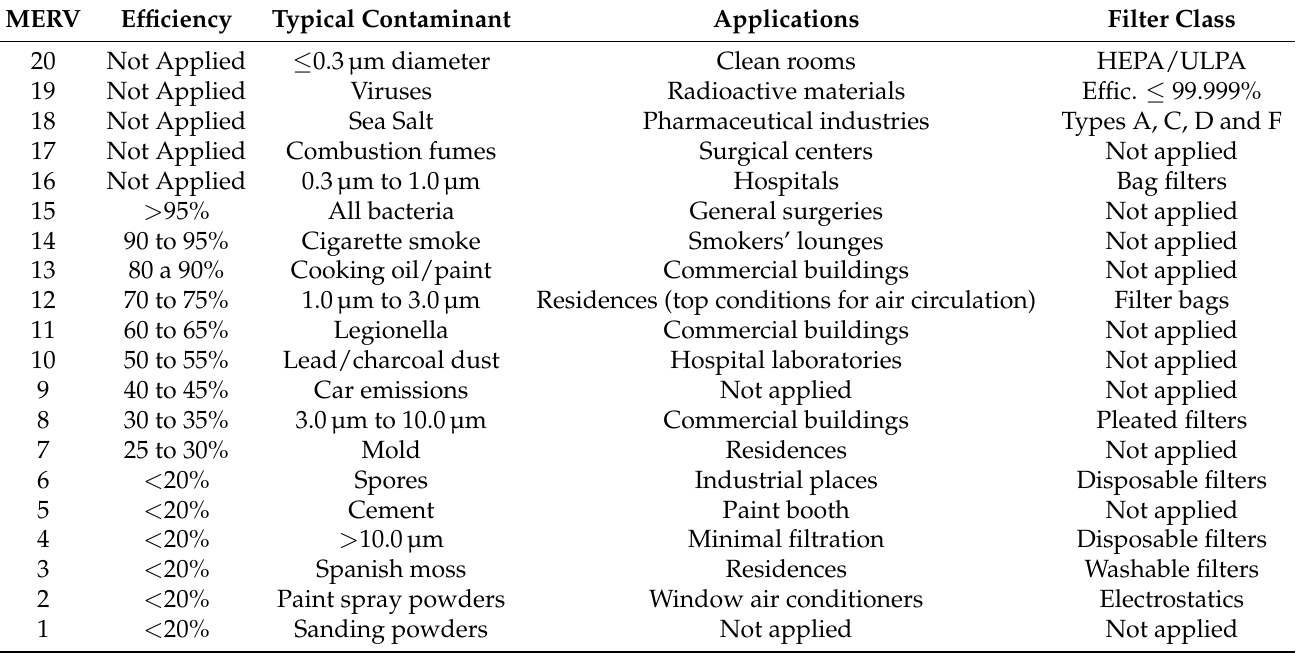
Table 1. MERV filter classification according to ASHRAE 52.1/52.2 standards. Source: